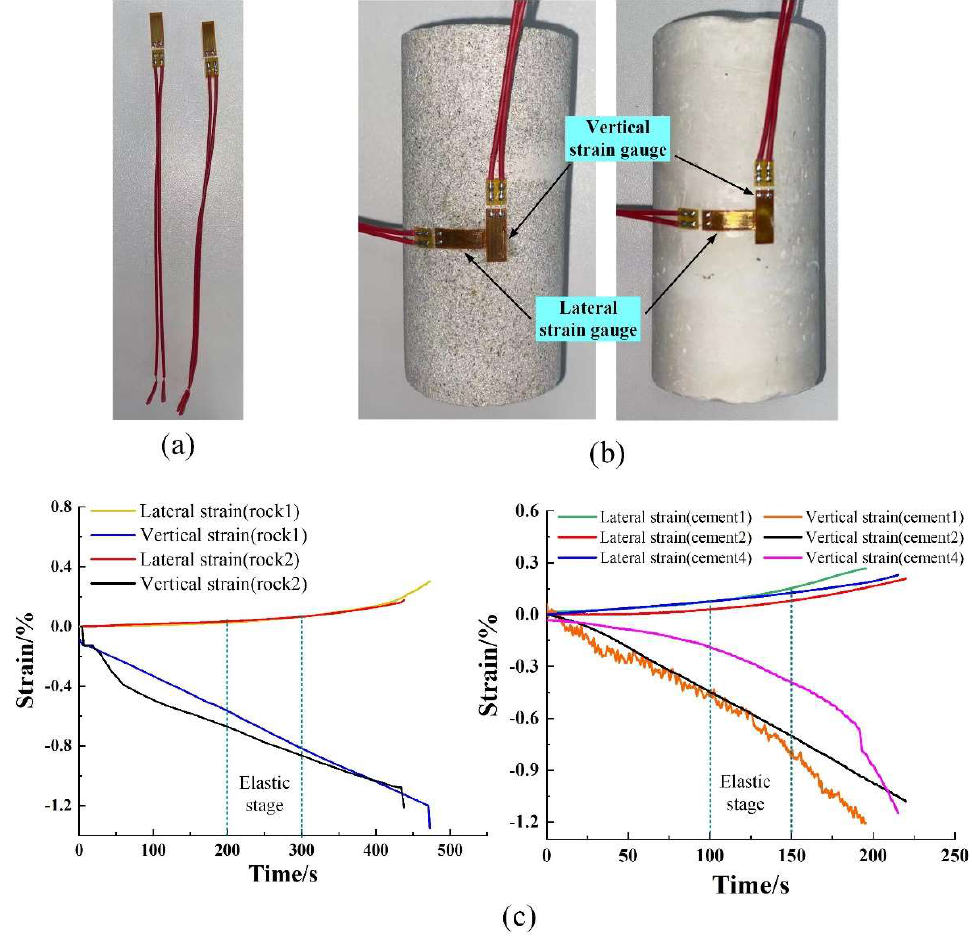
Figure 6. Strain gauges installation and strain data: ( a ) strain gauge; ( b ) strain gauges installation; ( c ) strain–time curves of cylindrical samples.